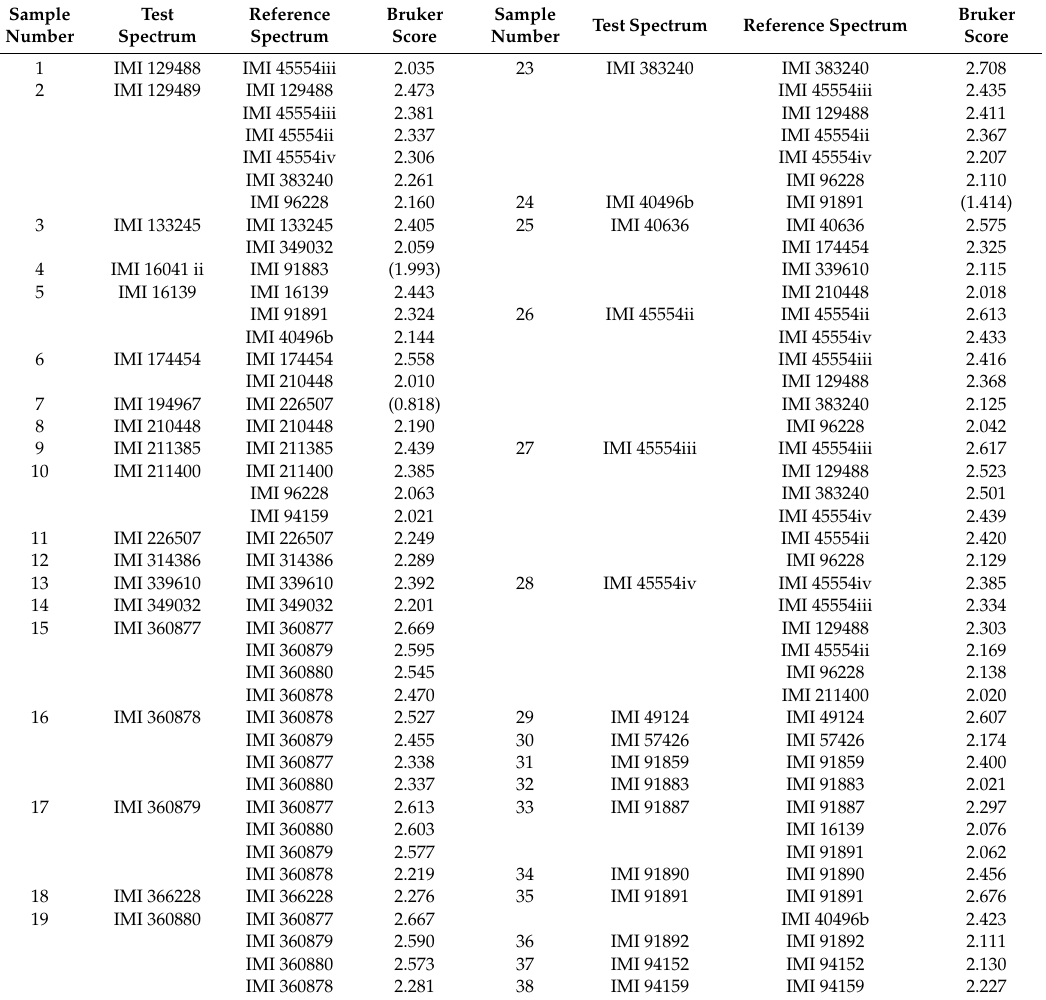
Table 2. Bruker scores for spectral comparison between plate-1 reference samples and plate-2 test